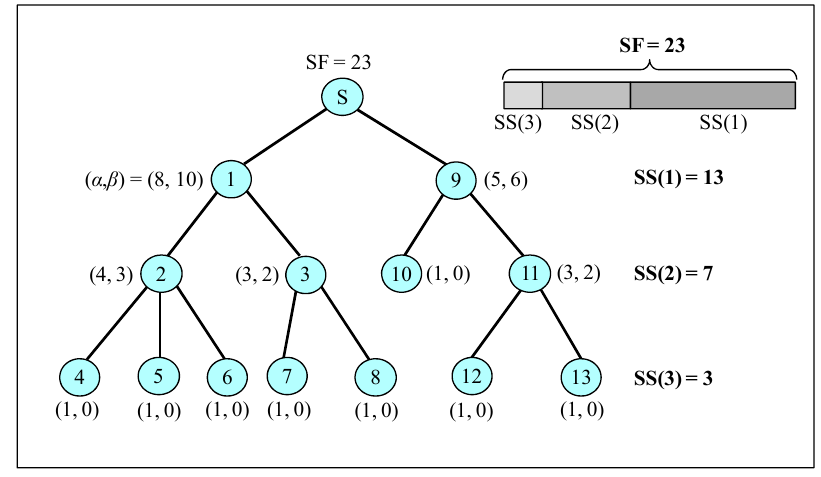
Figure 4. Bandwidth-demand calculation and the corresponding size of a sharable slot.